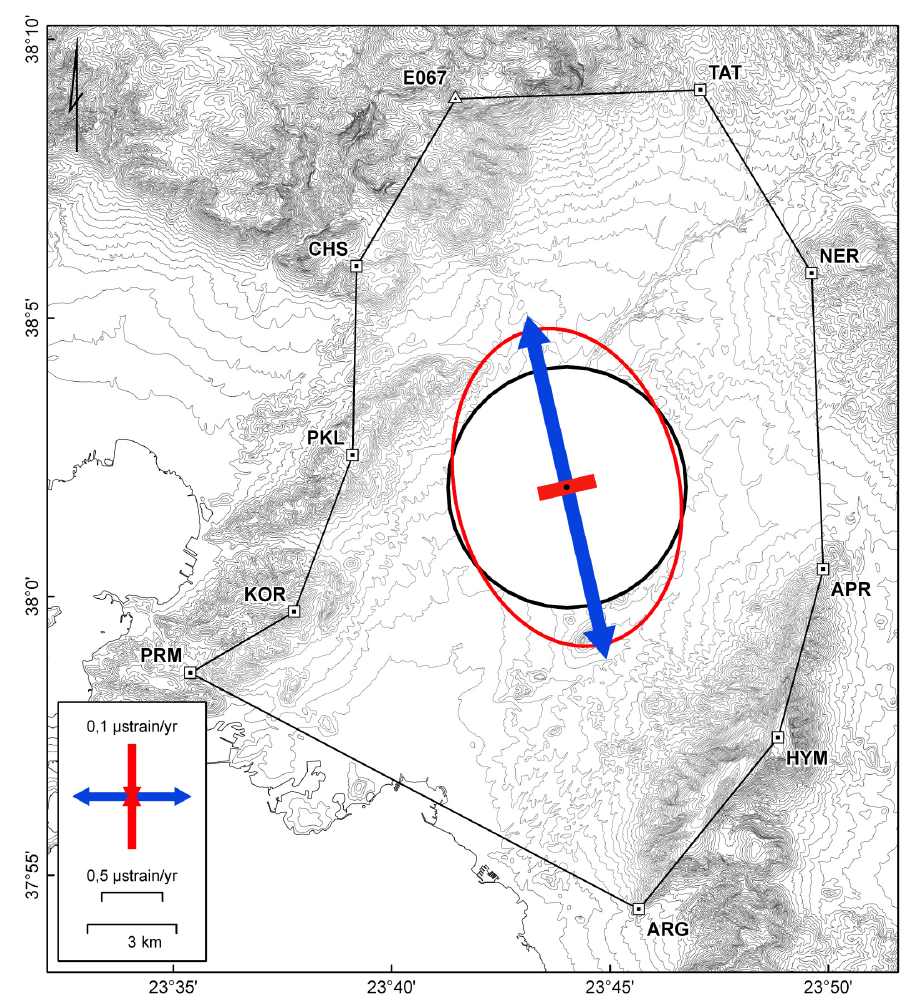
Figure 4. Principle axes of the strain rate tensor for the area of interest, calculated from velocities of selected GPS sites, in background topo- graphic contour lines of 20m interval. An extension rate of 0.27 ±0.06 10 -6 yr -1 along a NNW-SSE direction (N 347°) is